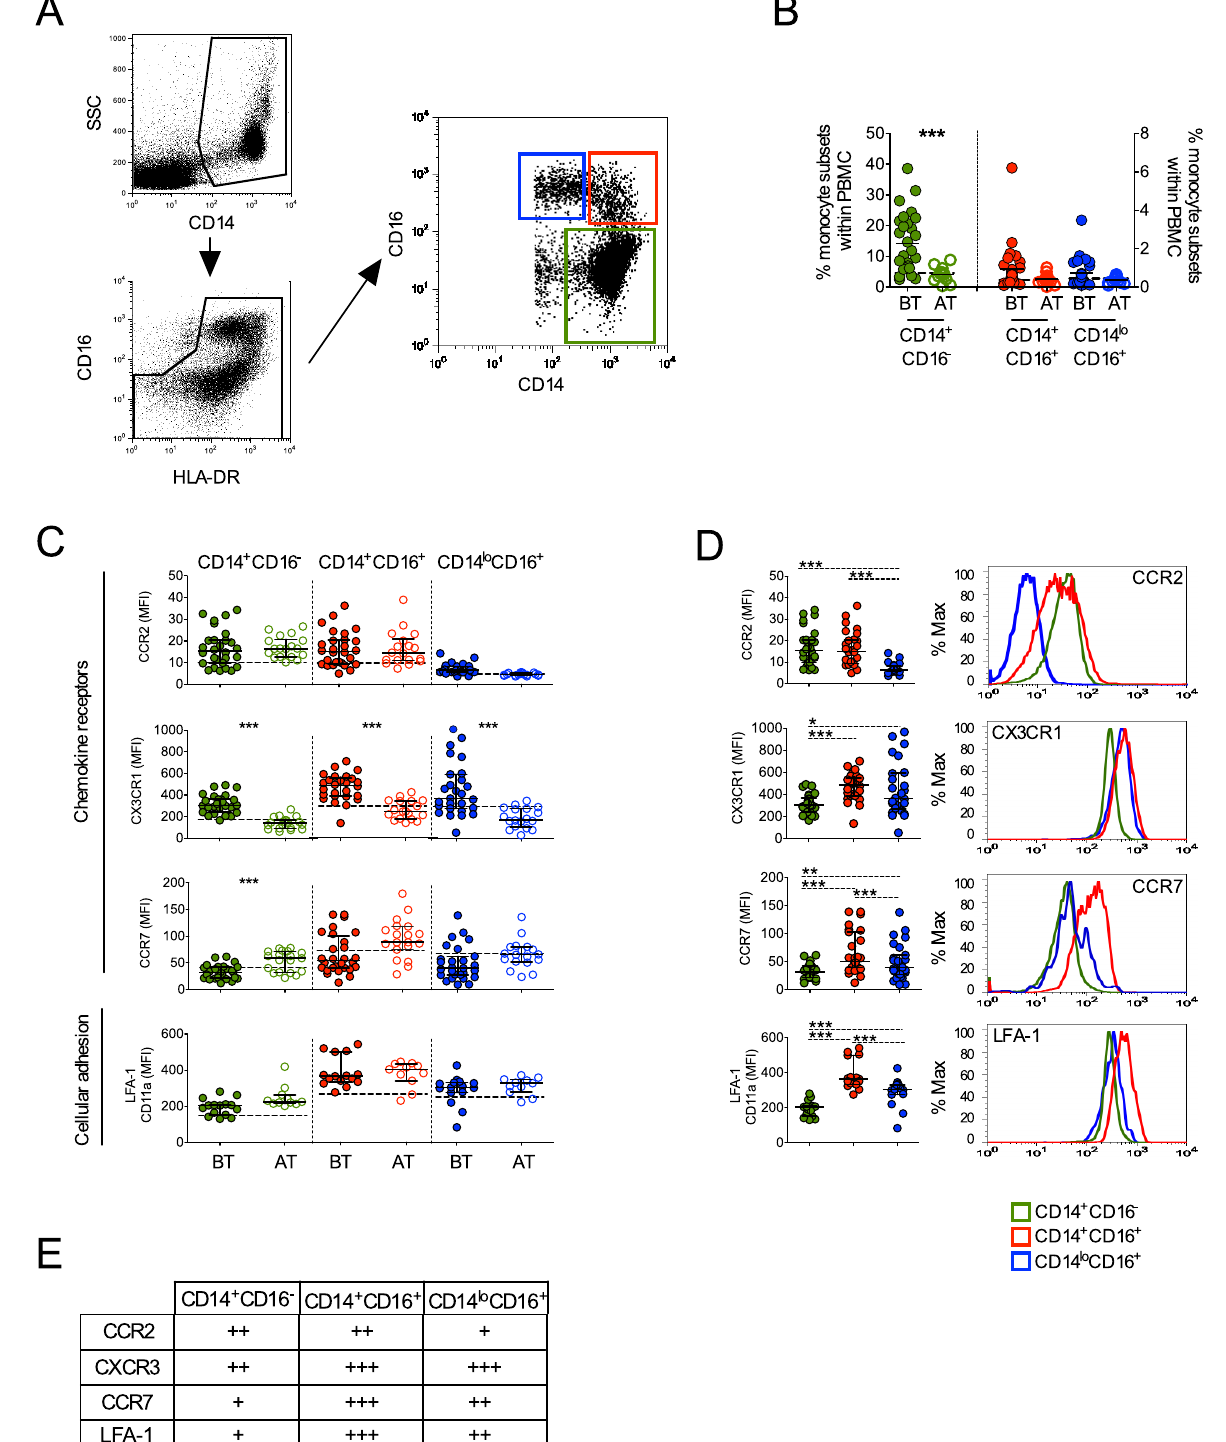
Figure 3. Characterization of monocyte subsets in malaria patients. (A) Representative dot plots showing the gate strategy for the identification of CD14 + CD16 2 (green gate), CD14 + CD16 + (red gate), CD14 lo CD16 + (blue gate) monocyte subsets. CD14 + CD16 2 , CD14 + CD16 + and CD14 lo CD16 + monocytes are represented by green, red and blue symbols. (B) Frequencies of CD14 + CD16 2 , CD14 + CD16 + and CD14 lo monocytes within PBMC from P. vivax -infected patients before (BT, filled symbols) and 30–45 days after treatment (AT, open symbols) (n=28). (C) Mean fluorescence intensity (MFI) of CCR2 (BT, n=28 and AT, n=18), CX3CR1 (BT, n=26 and AT, n=19), CCR7 (BT, n=28 and AT, n=19) and LFA-1 (BT, n=15 and AT, n=11) (from the top to the bottom) was evaluated on monocyte subsets (CD14 + CD16 2 (left panel), CD14 + CD16 + (middle panel), CD14 lo CD16 + (right panel)) from P. vivax -infected subjects, before and 30–45 days after treatment. Dotted lines represent medians of a given measurements from healthy donors. (D) Scattered dot plots (left panels) and representative histograms (right panels) showing MFI of the molecules